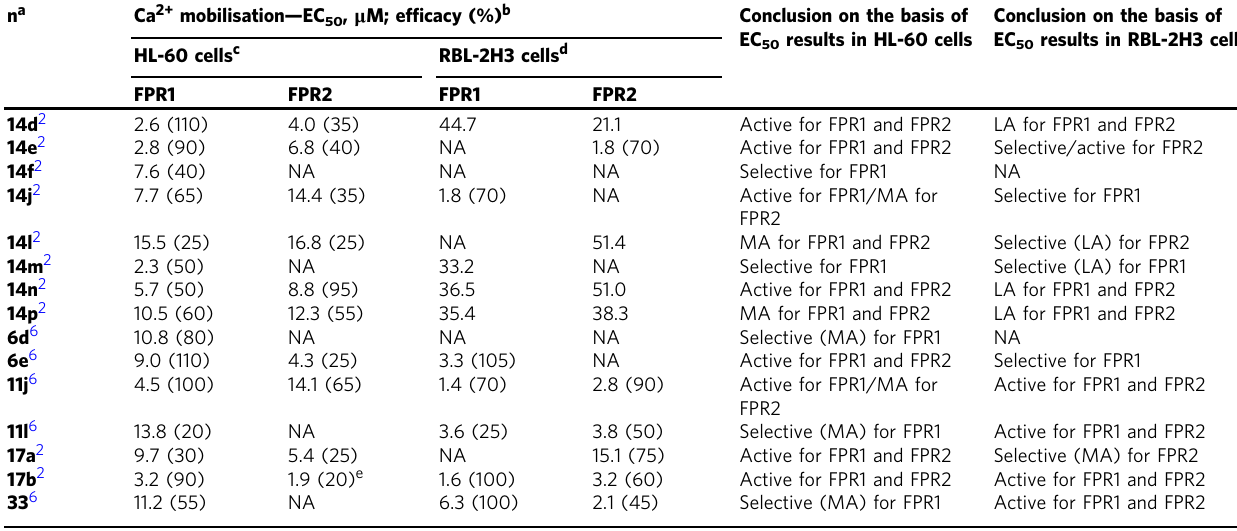
Table 1 Biological activity evaluation (i.e. agonism, through Ca 2+ mobilisation) of selected ligands for FPR1 and FPR2 in HL-60 and RBL-2H3 transfected cells n a Conclusion on the basis of